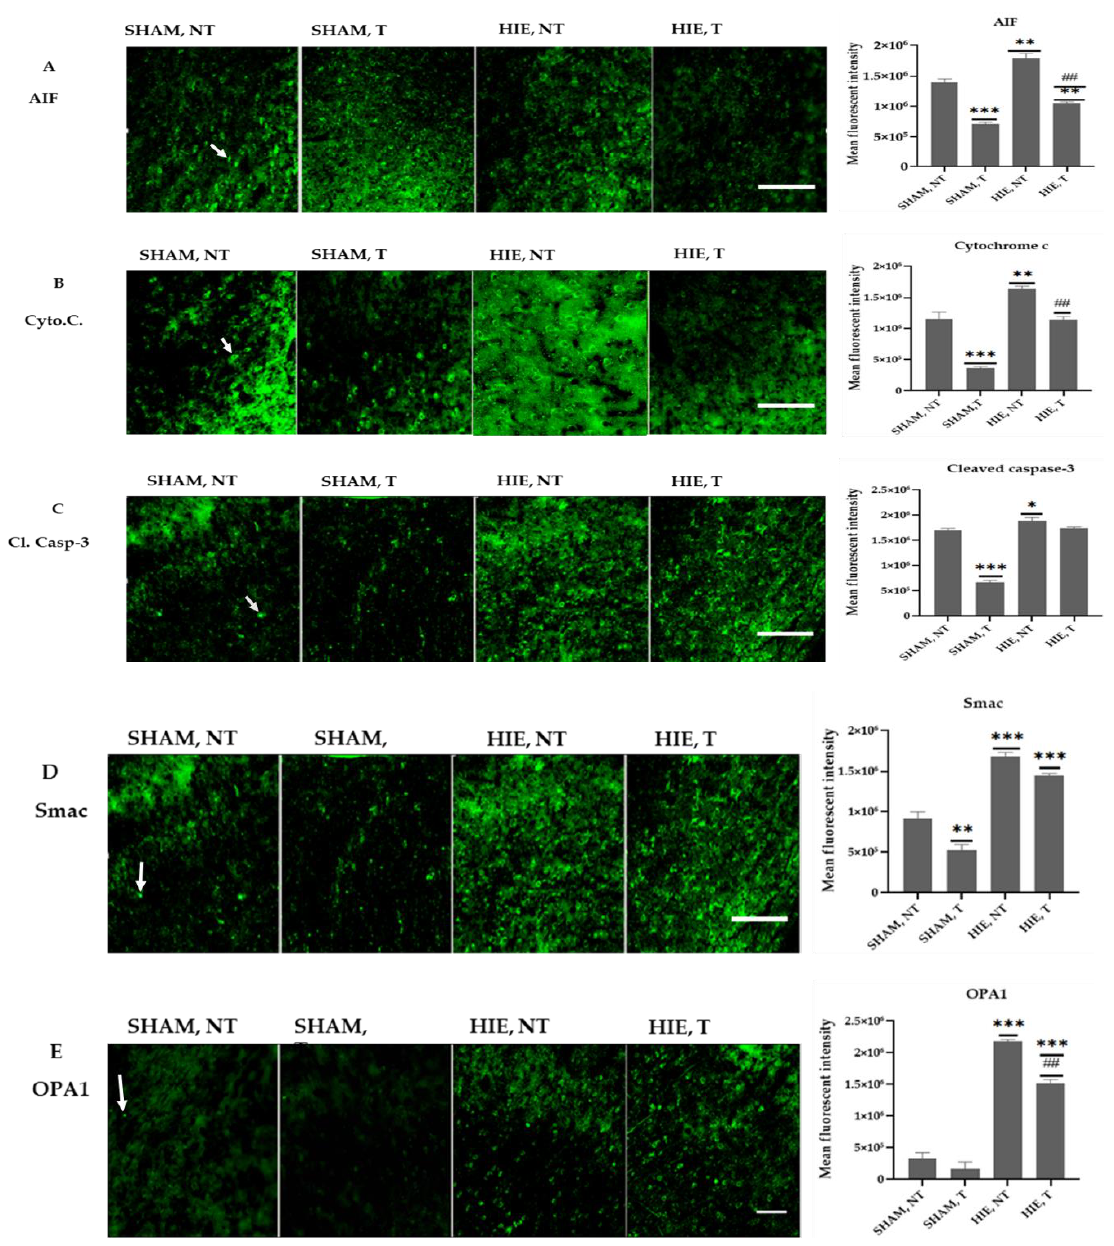
Figure 6. Immunofluorescence images and mean fluorescent intensities of the proteins in the motor cortex. ( A ) Representative immunofluorescence images and MFI of AIF in the motor cortex of each group. AIF molecules are green. AIF molecules were analyzed in the motor cortex. Results are presented as the Mean ± SEM of 3 rats from each group. (** p < 0.001 and *** p < 0.0001) compared with the SHAM, NT group; ( ## p < 0.001 compared with the HIE, NT group; each group, n = 3). Scale bar, 100 µm. ( B ) Representative immunofluorescence images and MFI of Cytochrome C in the motor cortex of each group. Cytochrome C molecules (green) were analyzed in the motor cortex. Data are presented as the Mean ± SEM of 3 rats from each group. (** p < 0.001 and *** p < 0.0001) compared with the SHAM, NT group; ( ## p < 0.001 compared with the HIE, NT group); each group, n = 3. Scale bar, 100 µm. ( C ) Representative immunofluorescence images and MFI of Cleaved caspase-3 in the motor cortex of each group. Cleaved caspase-3 molecules (green) were analyzed in the motor cortex. Results are presented as the Mean ± SEM of 3 rats from each group. (* p < 0.05 and *** p < 0.0001) compared with the SHAM, NT group); each group, n = 3. Scale bar, 100 µm. ( D ) Representative